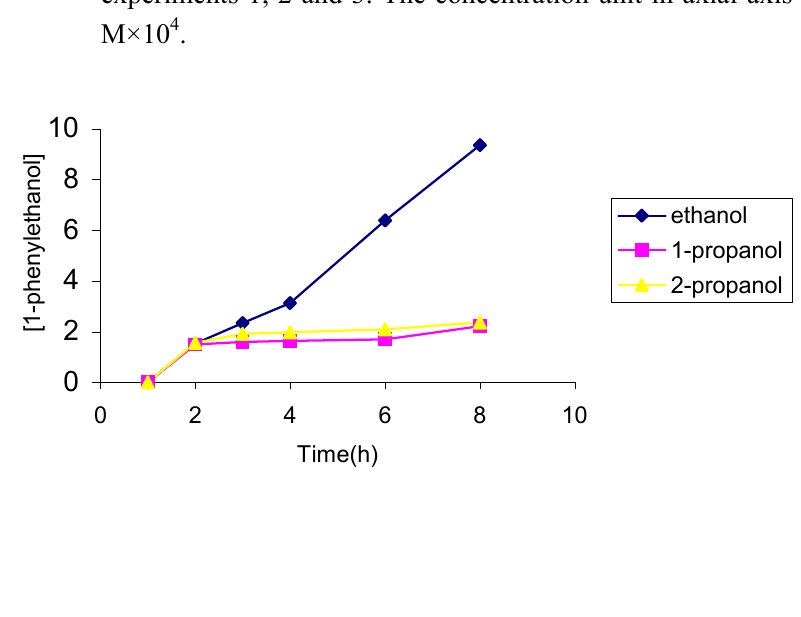
Figure 3 . Variation of the 1-phenylethanol concentration vs. time for experiments 1, 2 and 3. The concentration unit in axial axis is M×10 4